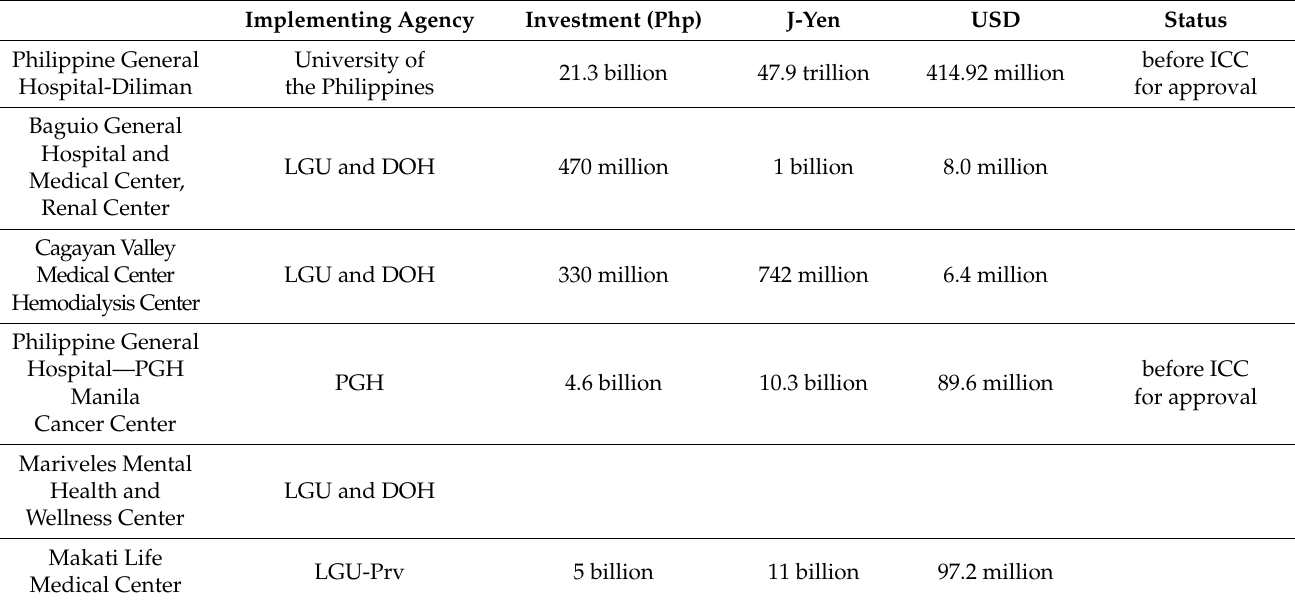
Table 2. List of Pipeline Public–Private Health Infrastructure Projects (as of February